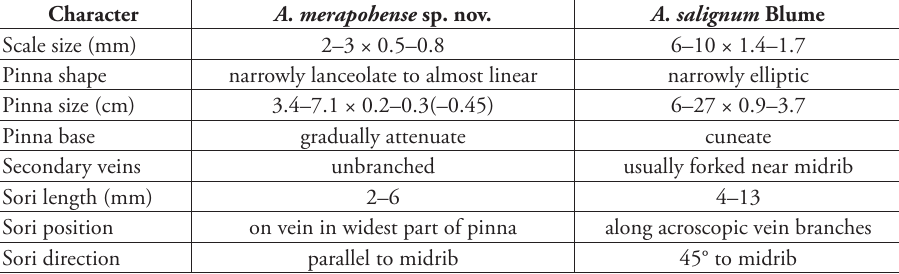
Table 1. Differences between Asplenium merapohense and A. salignum.